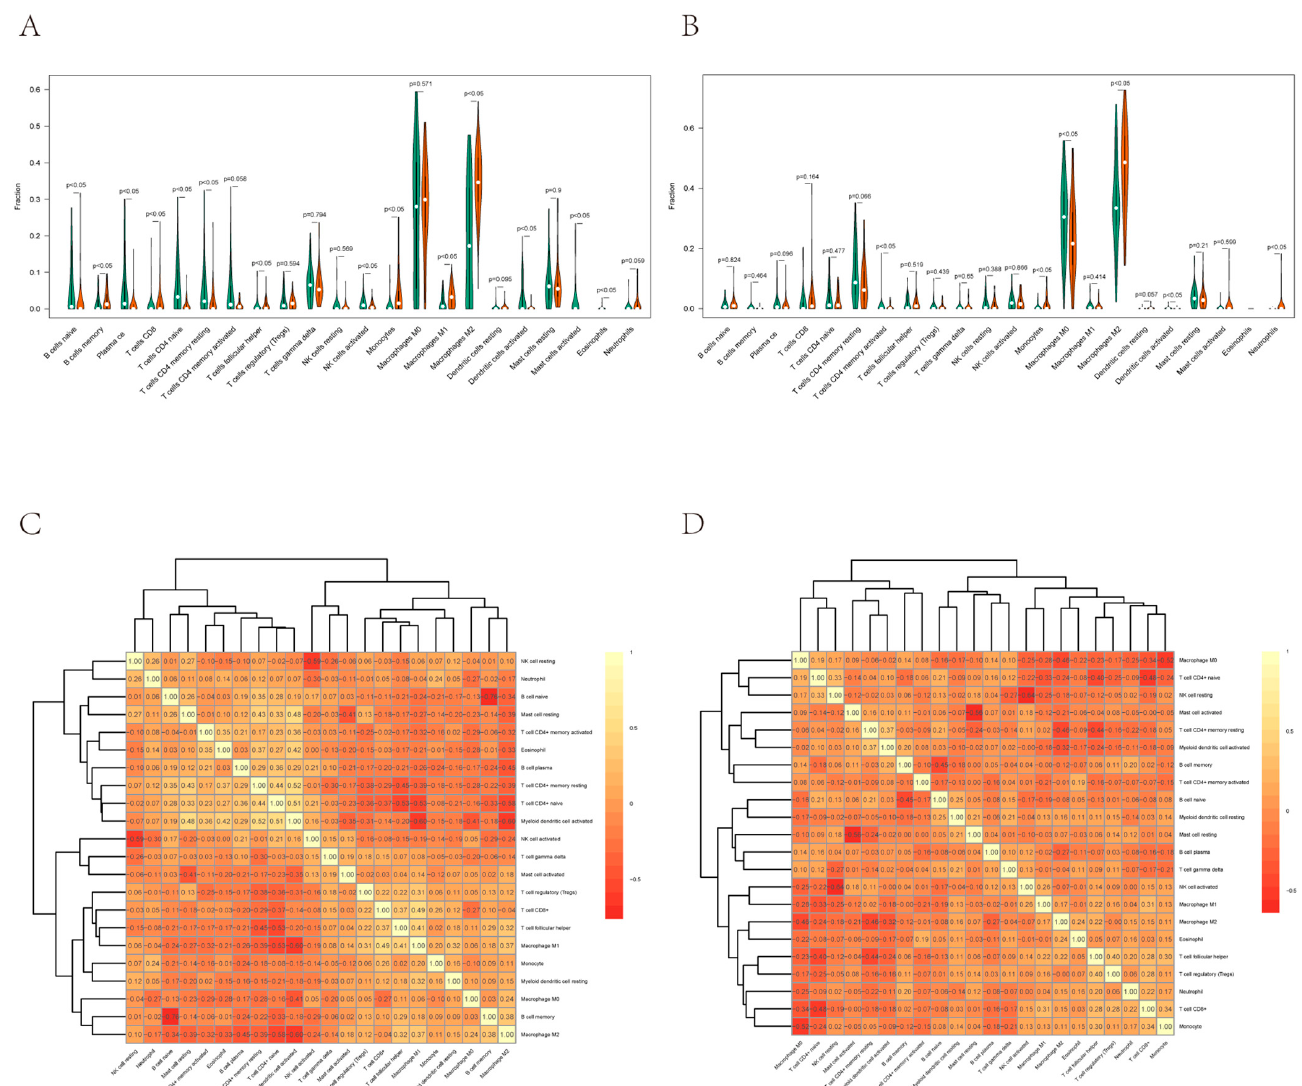
Figure 5. Differences in immune cell infiltration and correlations. ( A , B ) The CIBERSORT package was used to calculate differences in the infiltration of 22 kinds of immune cells between the high and low EVI2B expression groups in 103 osteosarcoma samples from the test set ( A ) and validation set ( B ). Green represents the low expression group and orange represents the high expression group in the violin plot. ( C , D ) Heat map of immune cell correlations in the test set ( C ) and validation set ( D ). Darker colors indicate a more significant correlation.